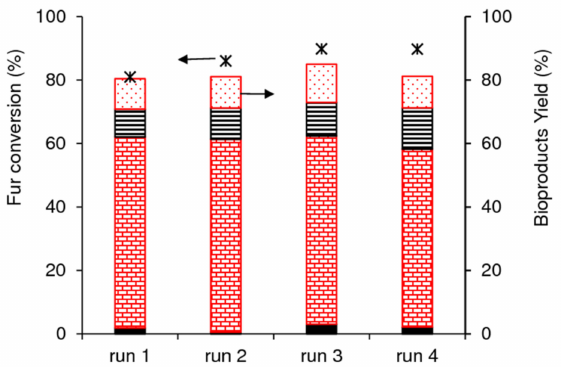
Figure 9. Consecutive batch runs of Fur reaction in the presence of Hf-TUD-1(75) at 150 ◦ C; Fur conversion (*), and yield of FA (black bars), 2BMF (red bricks), 2BL (black stripes), AnL (red dots). Reaction conditions: 0.2 M Fur in 2BuOH, 20 g cat L − 1